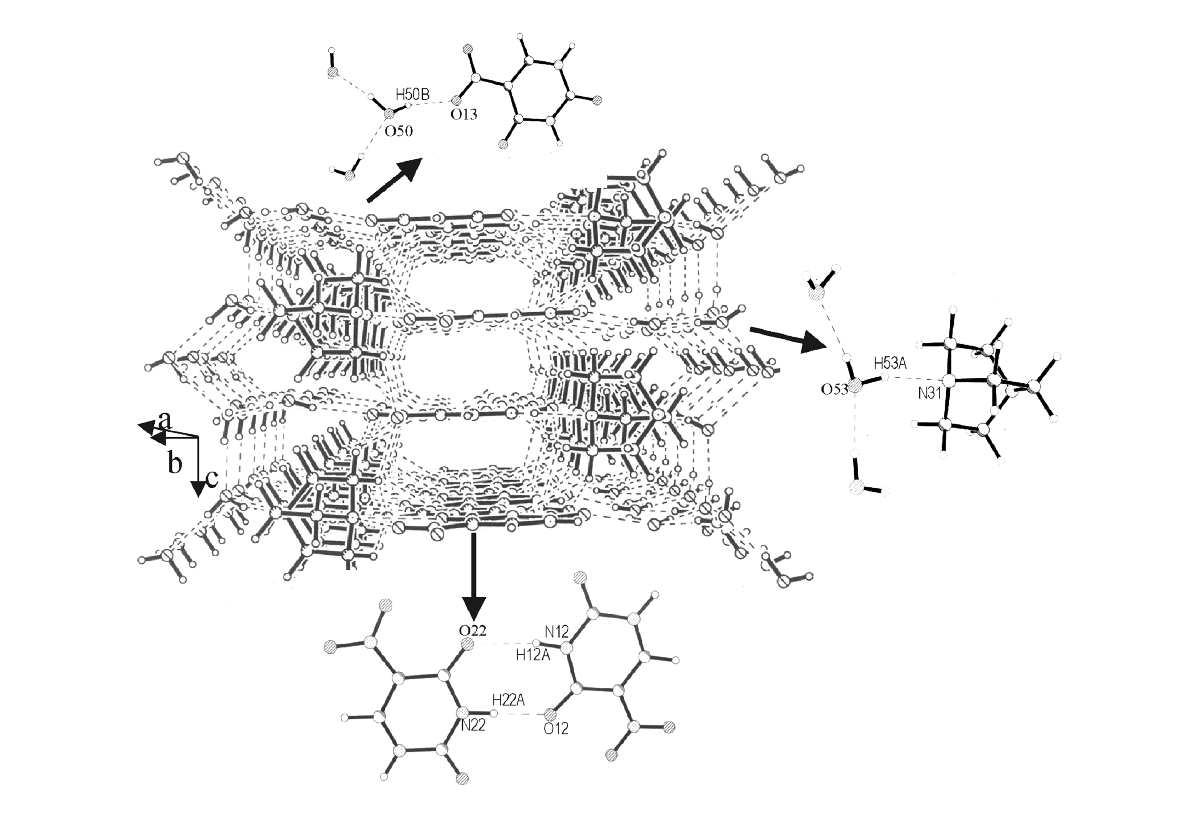
Figure 8: Cocrystal of I and DABCO: A view along the diagonal of the ab plane showing the supramolecular assembly. Inset shows some important hydrogen bonding patterns.